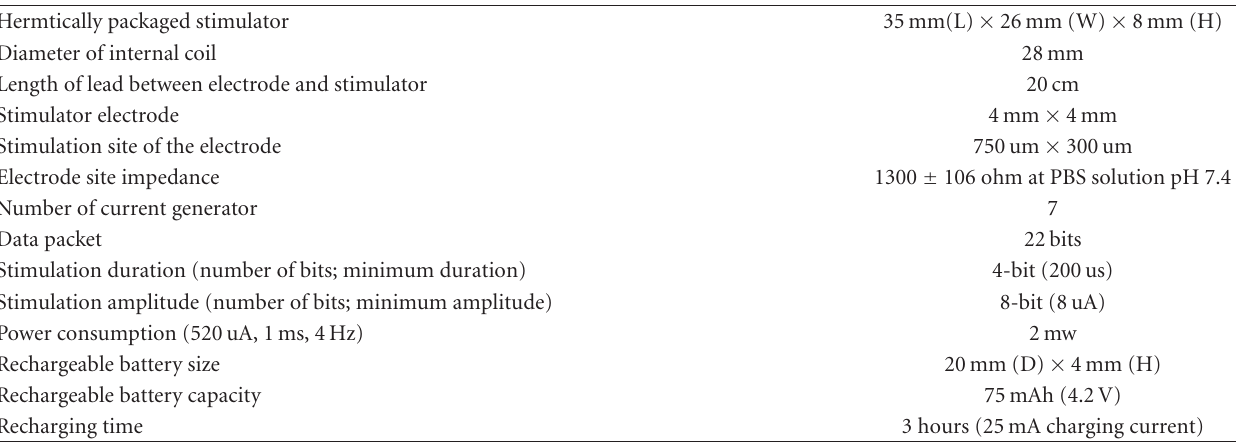
Table 2: Specification summary of the implanted stimulator.